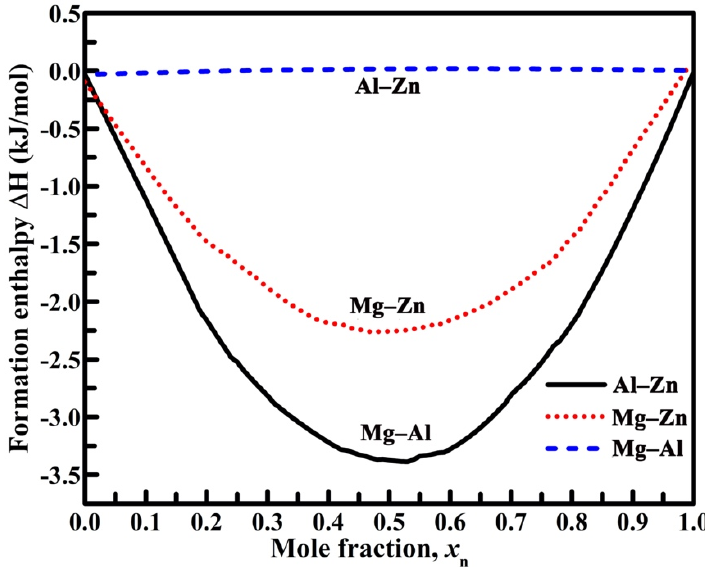
Figure 9. The formation enthalpy of binary phases of Mg-Al, Mg-Zn and Al-Zn compounds in the Mg-Al-Zn system.